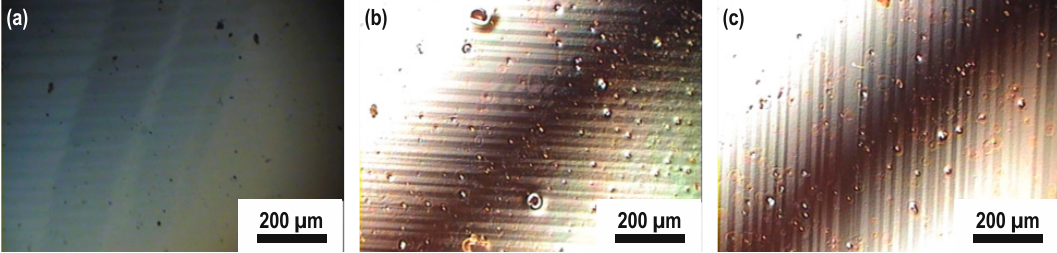
Figure A4. Surfaces of BPFMO films as observed by optical microscopy with X10 objective using Differential Interference Contrast (DIC) for ( a ) 5% Pr substitution and ( b ) – ( c ) 12.5% substitution.